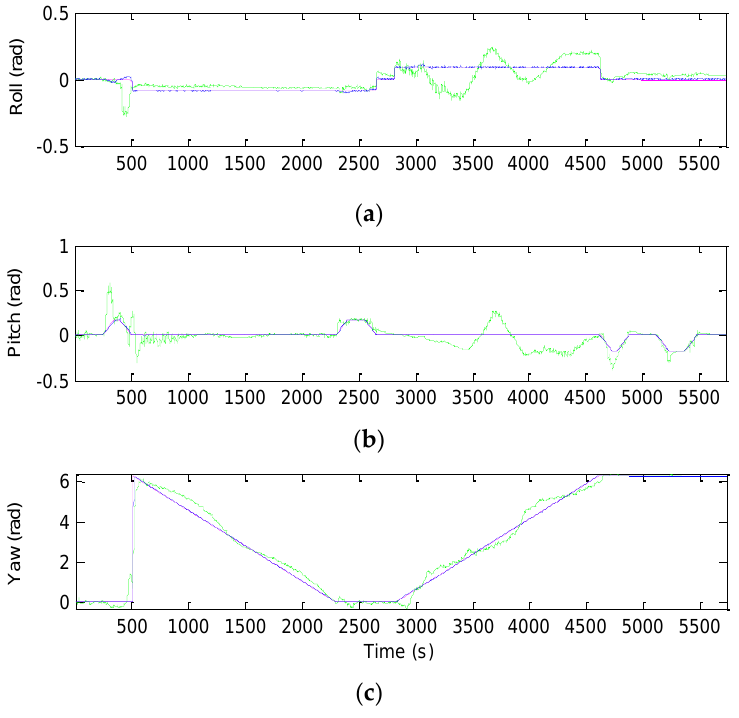
Figure 13. Comparison of Euler angle estimation results: UKF (in green) versus CKF (in blue)—Scenario 2. ( a ) Roll angle; ( b ) Pitch angle; ( c ) Yaw angle.